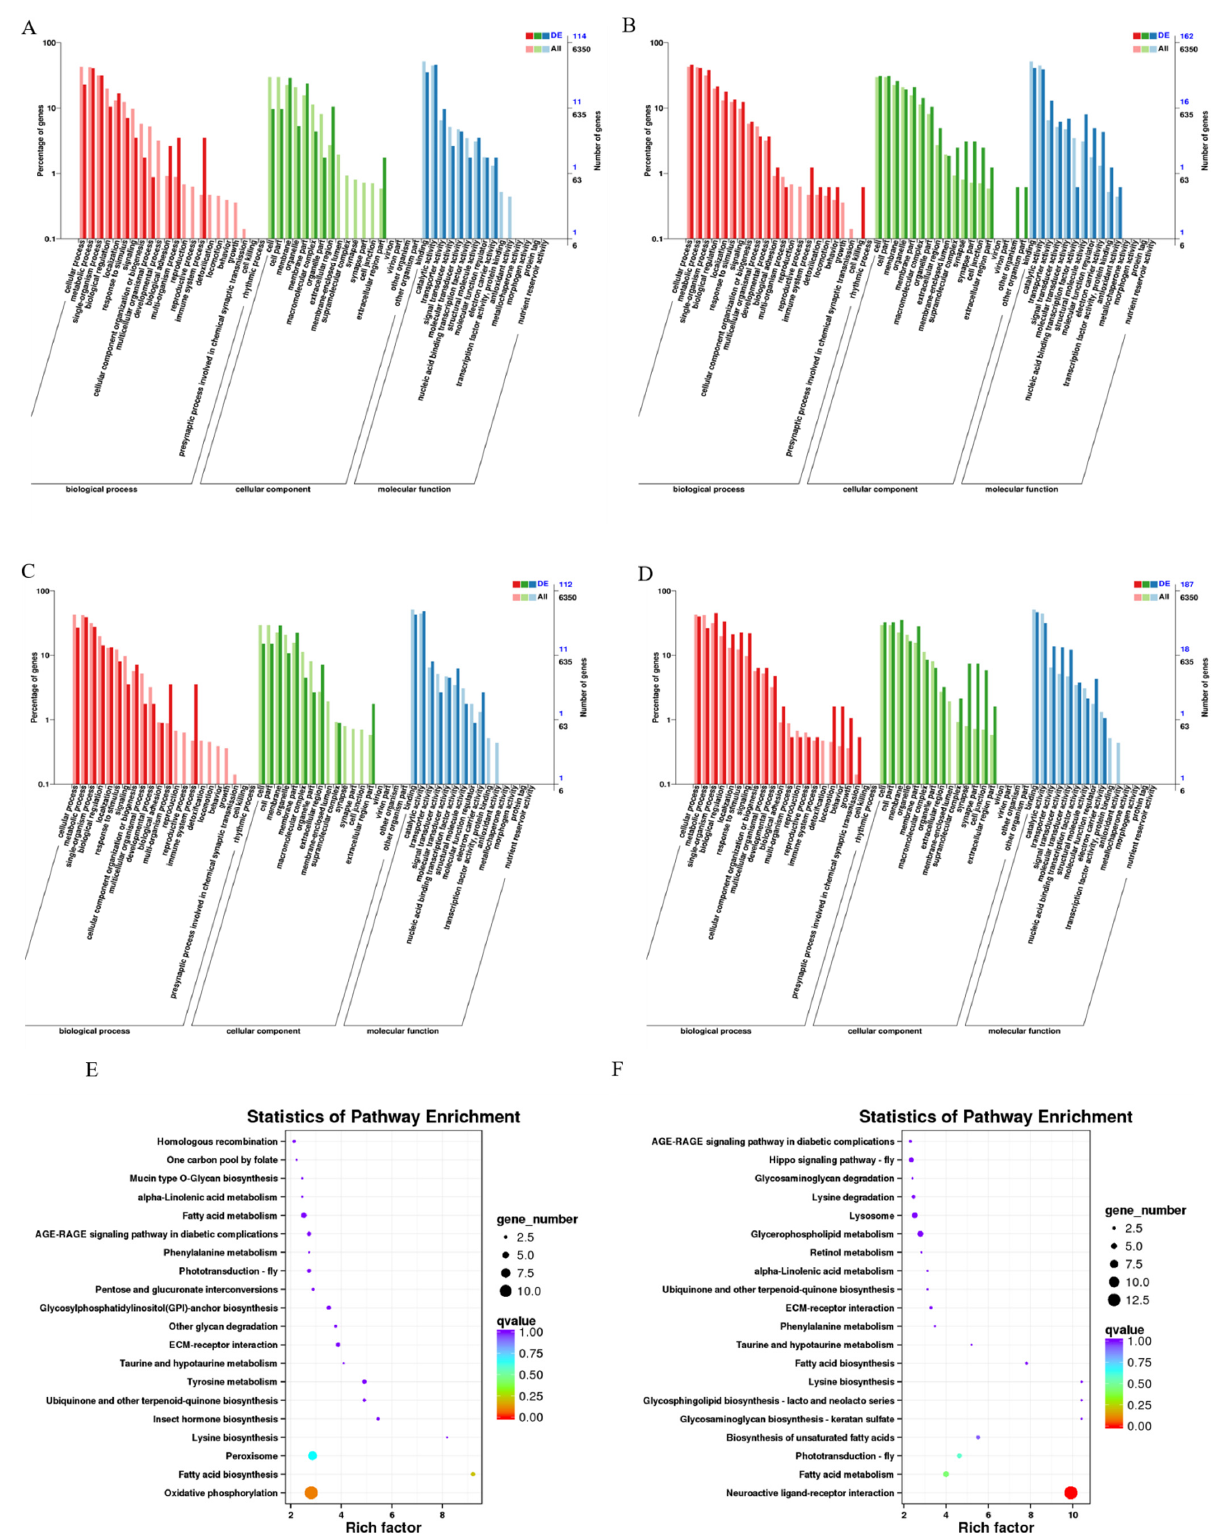
Figure 4. GO (Gene Ontology) enrichment analysis of differentially expressed genes (DEGs). ( A ) Upregulated DEGs distribution of the control group and LC 5 group; ( B ) downregulated DEGs distribution of the control group and LC 5 group; ( C ) upregulated DEGs distribution of the control group and LC 20 group; ( D ) downregulated DEGs distribution of the control group and LC 20 group; ( E , F ) KEGG enrichment analysis of DEGs; ( E ) DEGs distribution of the control group and LC 5 group; ( F ) DEGs distribution of the control group and LC 20 group.